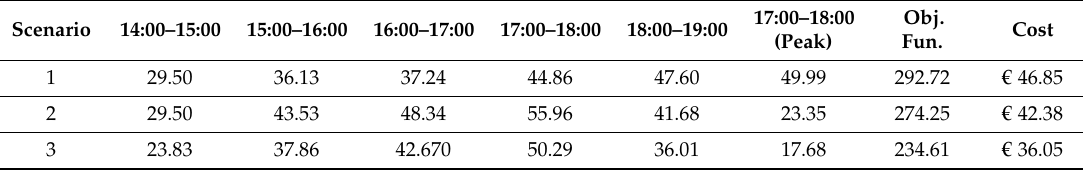
Table 4. Comparison between scenarios 1, 2, and 3.